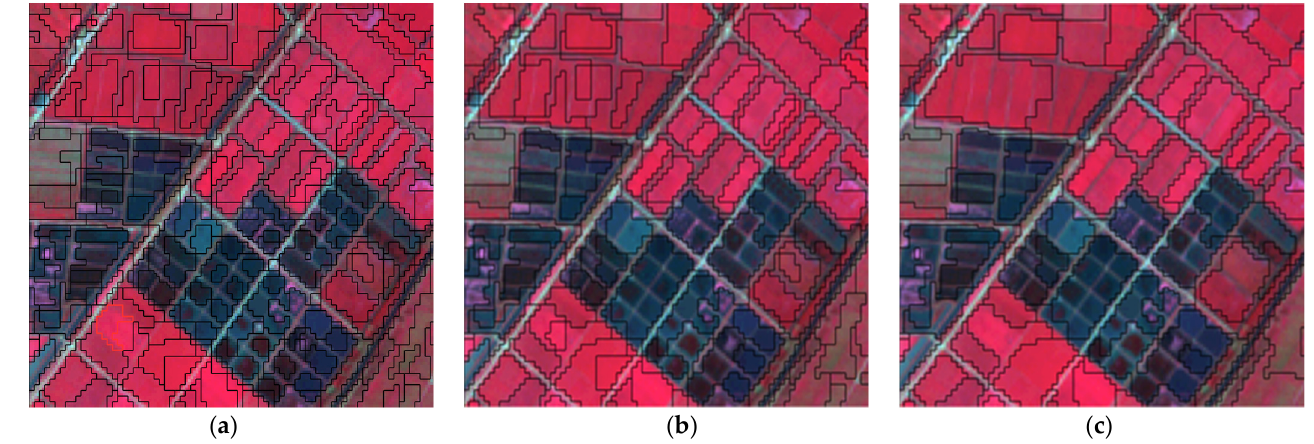
Figure 3. Segmentation results of the segmentation scales of ( a ) 50, ( b ) 75, and ( c ) 100. ( a – c ) show the false-color composite images.